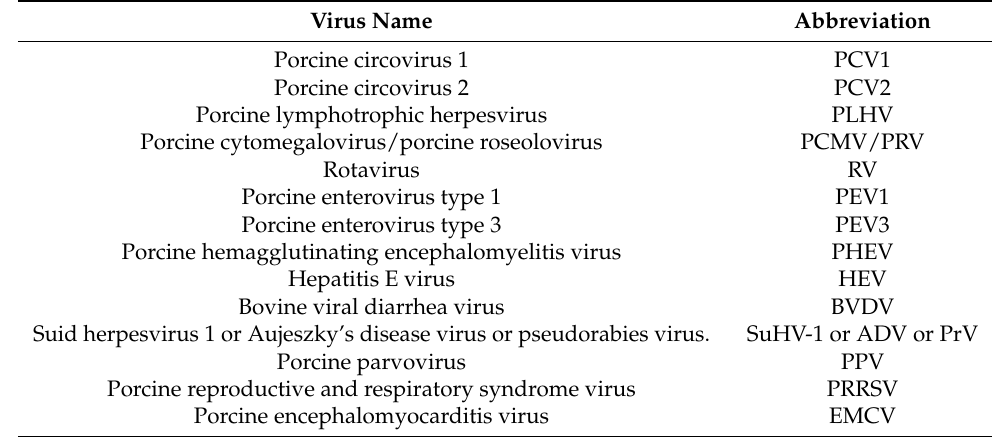
Table 2. Viruses absent in Auckland Island pigs used for clinical islet cell xenotransplantations